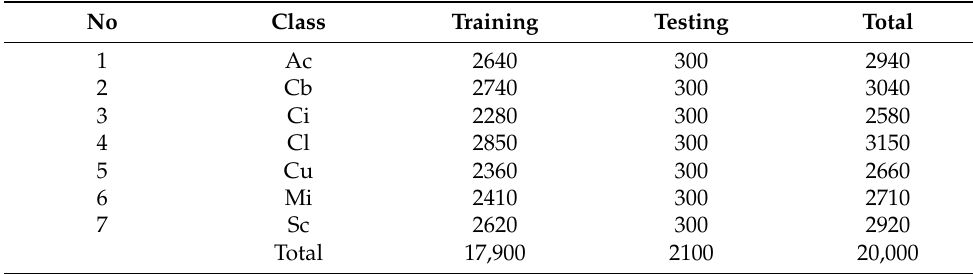
Table 2. Training and testing samples for the ASGC dataset.